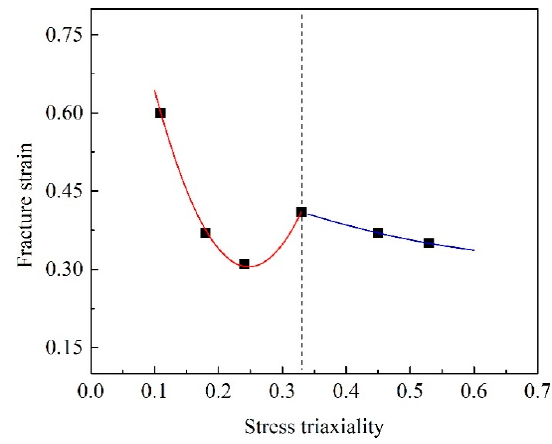
Figure 14. The relationship between stress triaxiality and fracture strain.